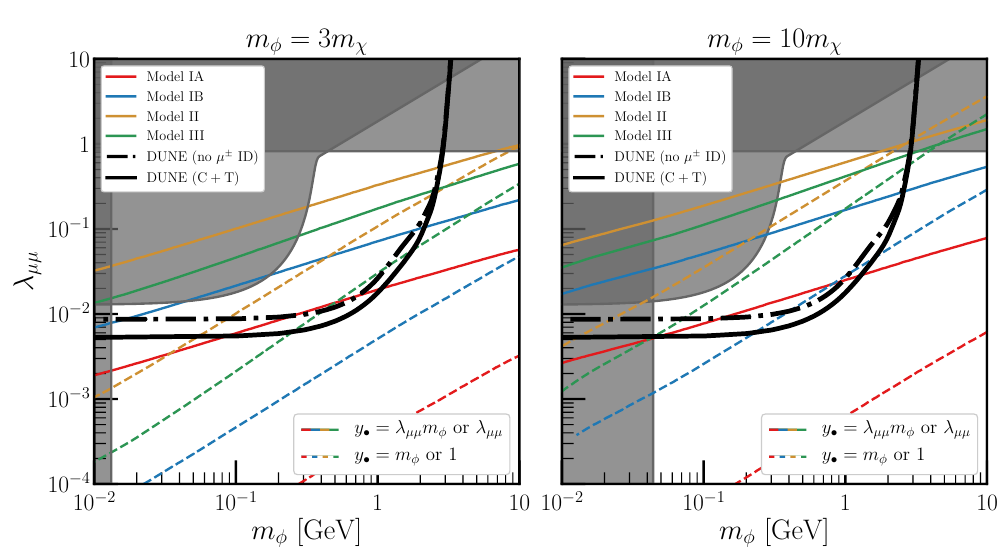
Figure 12.2: Expected DUNE sensitivity to a scalar φ with mass m φ and coupling to ν µ λ µµ assuming 10 years of data collection at the near detector. Solid black line: sensitivity using charge-identification techniques, Dot-dashed black line: no charge identification. Colored lines indicate thermal relic targets for the dark matter scenarios discussed in the